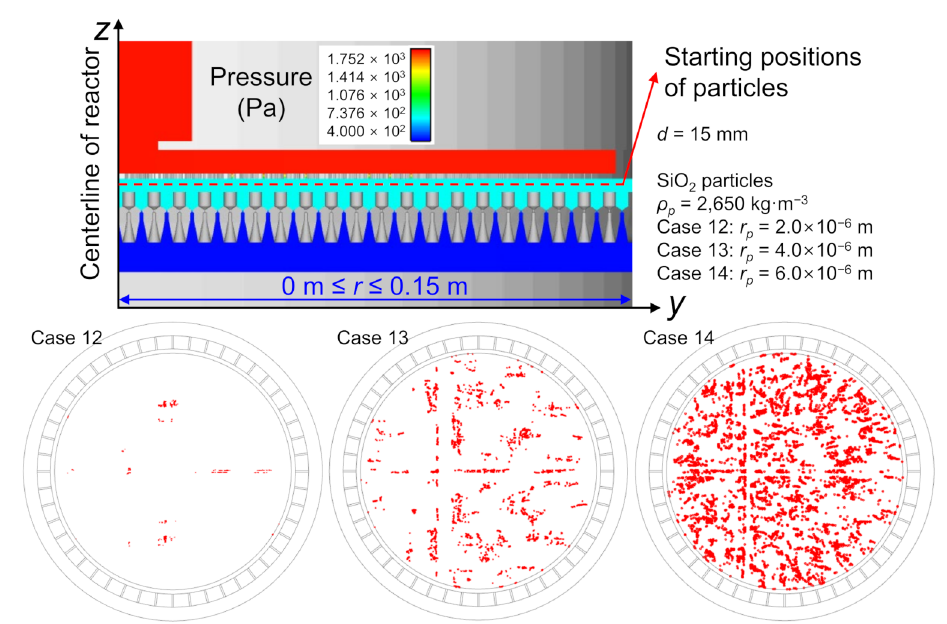
Figure 7. Starting positions of inertial particles are indicated. The spatial variation in the gas pressure ( p g , Pa) is plotted together for Case 3. Final positions of particles deposited on the heater surface depicted for Case 12 ( r p = 2.0 × 10 − 6 m, ρ p = 2650 kg · m − 3 , d = 15 mm), Case 13 ( r p = 4.0 × 10 − 6 m, ρ p = 2650 kg · m − 3 , d = 15 mm), and Case 14 ( r p = 6.0 × 10 − 6 m, ρ p = 2650 kg · m − 3 , d = 15